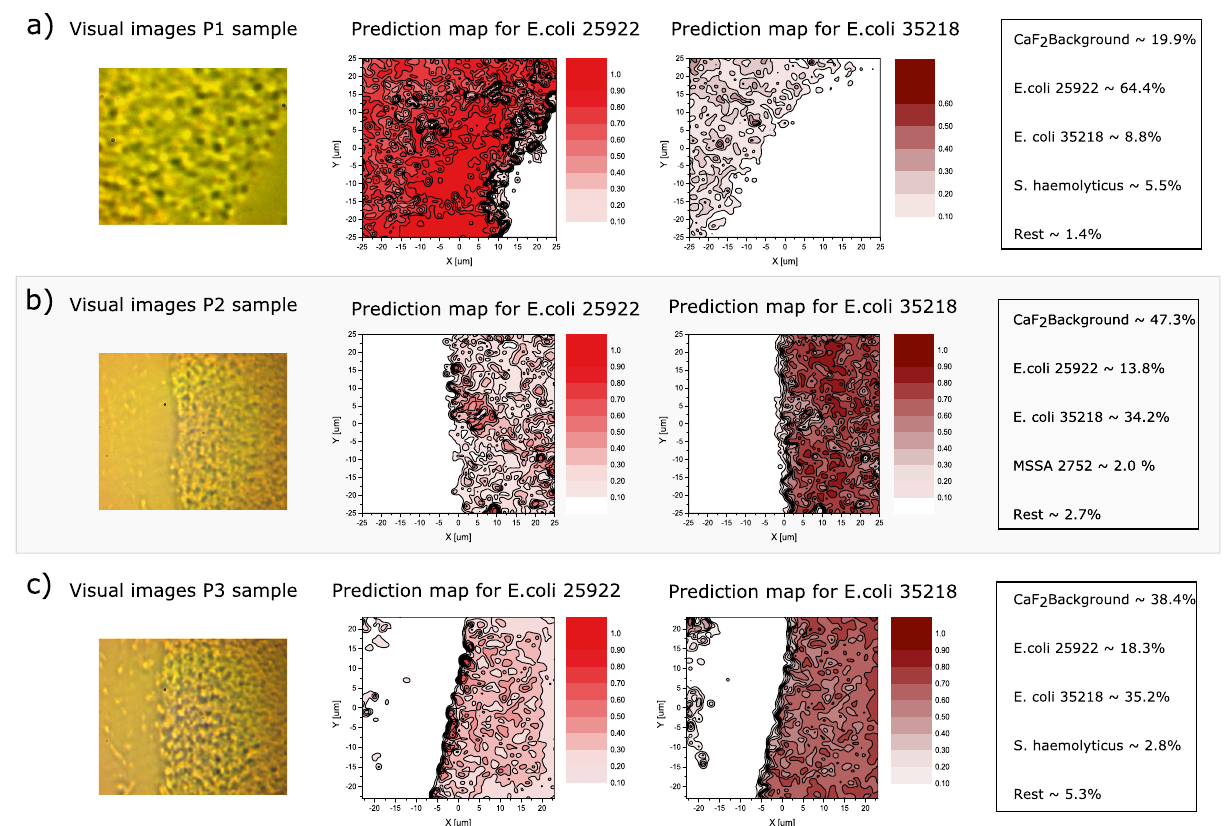
Figure 5. Raman measurements and ST classifications of three cultured E. coli patient samples. The figure shows the visual images of the measurement areas, where it can be seen that the bacteria distribution ranges again from a deep layer (4–6 µ m thick) to single bacteria depth and the ST prediction maps for E. coli ATCC 25922 and E. coli ATCC 35218. The size of the maps are 50 µ m × 50 µ m and they each consist of 2601 Raman spectra − 1 (700–1600 cm ) with 1 µ m spacing between the points. The integration time used is 0.5 second for acquiring the spectra and average 10 times per point/spectra. The table shows the overall prediction rates for CaF 2 background, E. coli ATCC 25922, E. coli ATCC 35218 and the rest of the classes. Specific we see that ( a ) Patient sample 1 has a overall prediction rate for the other bacteria of 6.9%, ( b ) Patient sample 2 of 4.7% and c) patient sample 3 of 8.1%. However, the accuracies (prediction rate >0.5) are for P1: 98.5%, P2: 99.4% and P3: 98% that the sample is E. coli